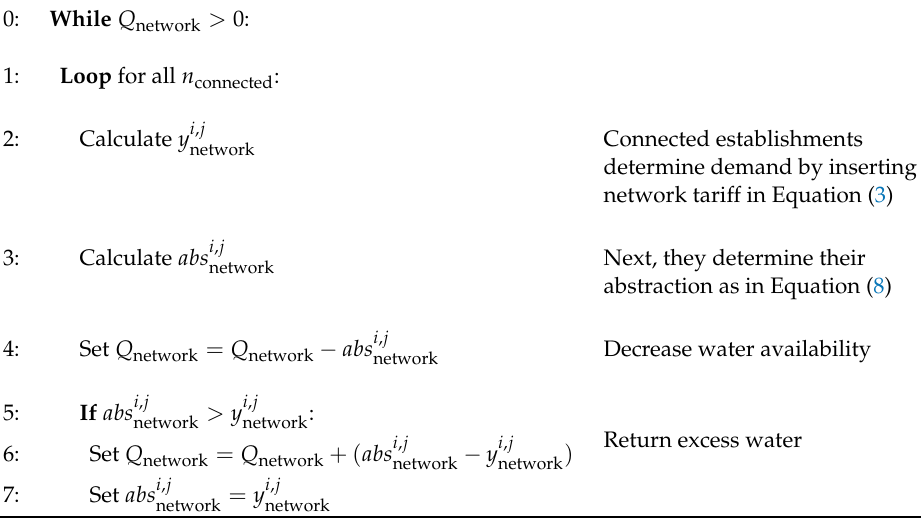
Table 3. Algorithm for the Network Water